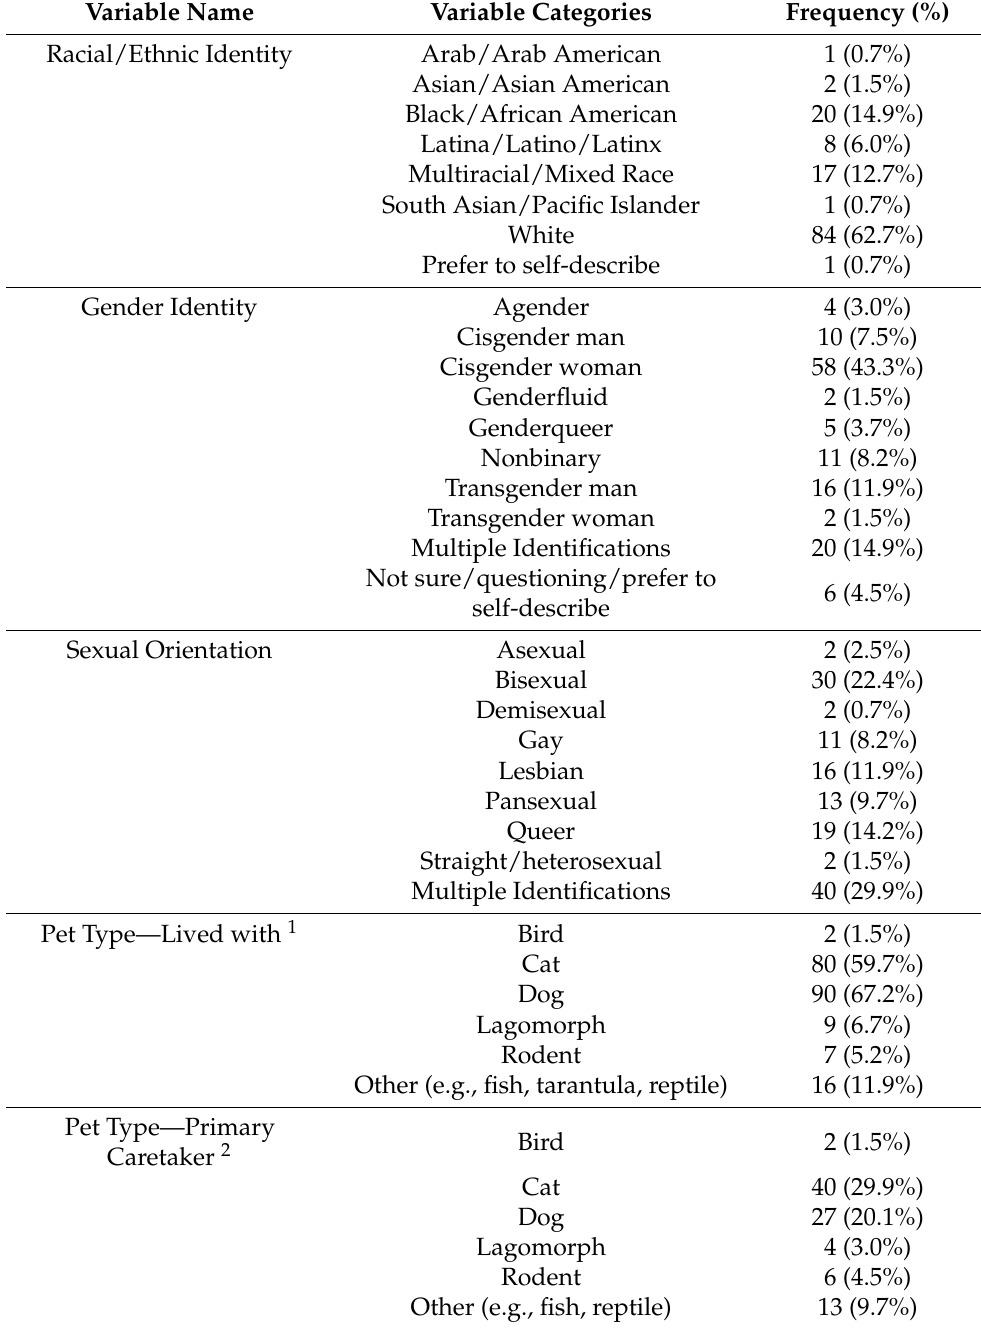
Table 1. Demographic information ( n =